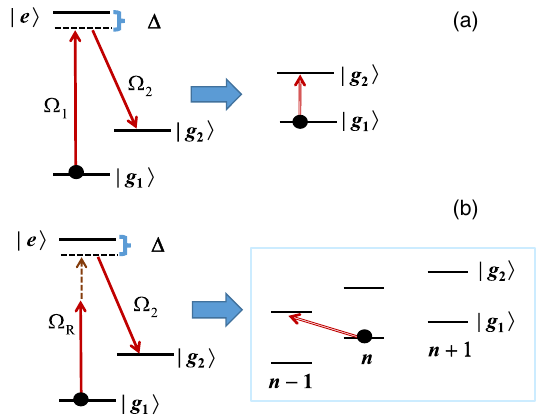
FIG. 1. (a) Schematic of a Λ -type three-level system driven by two optical fields with respective Rabi frequency, Ω 1 and Ω 2 . In the limit of large dipole detuning, Δ , the system becomes equivalent to an optically driven transition between the two lower states. (b) Schematic of a Λ -type three-level system driven by an acoustic field (brown dashed line) as well as two optical fields. The j g 1 i to j e i transition is a phonon-assisted transition with effective Rabi frequency Ω . In the limit of large Δ , the R system becomes equivalent to an optically driven transition between the phonon ladders of the two lower states, where n denotes the phonon